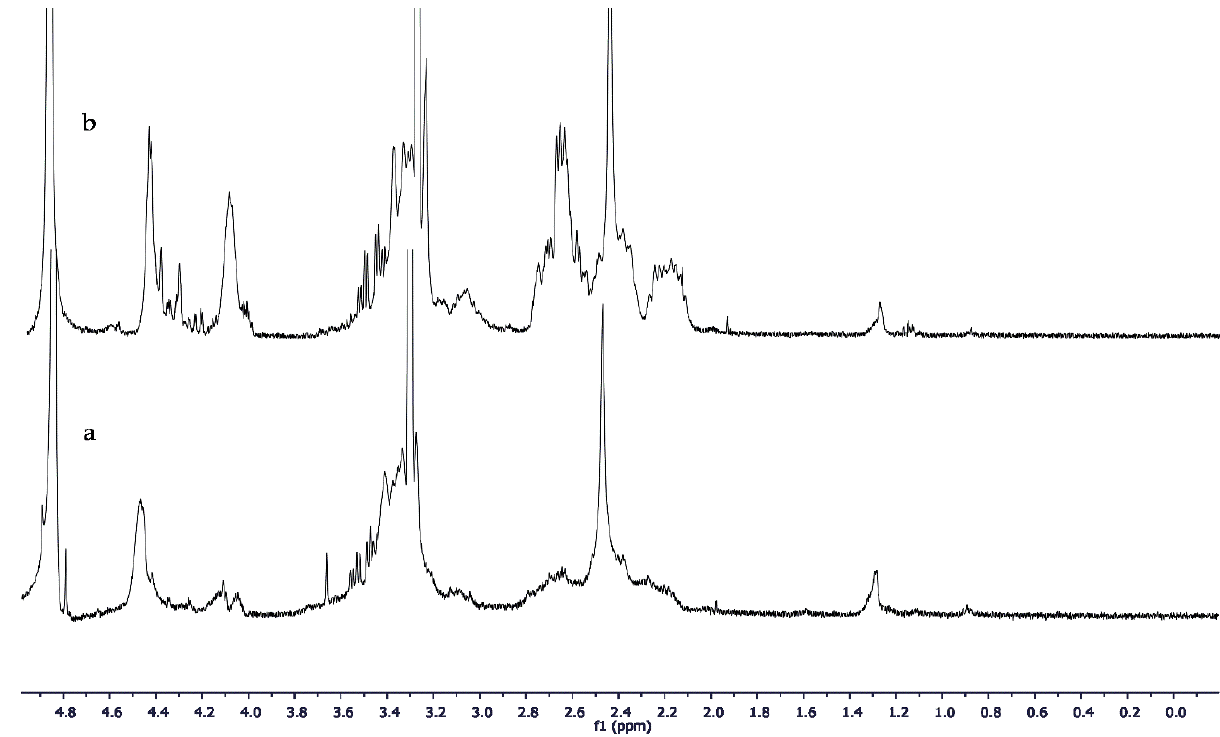
Figure 11. 1 H NMR spectra of ESTF after ( a ) and before ( b ) aging. The FT-IR spectrum of irradiated DF (Figure S39) shows changes mainly in the region 1600–1700 cm − 1 , probably attributable to a partial oxidation on the triamine units. In the 1 H NMR spectrum (Figure 12), the variation of the shape and relative intensity of the signals of CHNH in the 2–3 ppm zone can be observed. In particular, a new signal at 3.0 ppm appeared and the shape of the original CHNH area also